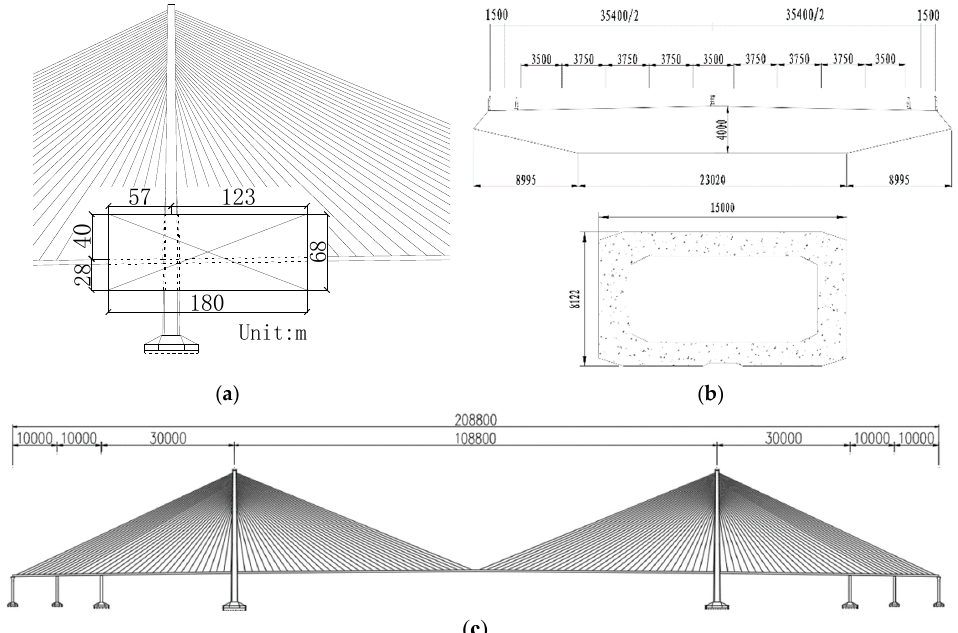
Figure 1. The size of Sutong Bridge. ( a ) Segmental model region. ( b ) Cross sections of the girder and the pylon column (unit: mm). ( c ) The profile image of the bridge (unit: mm).